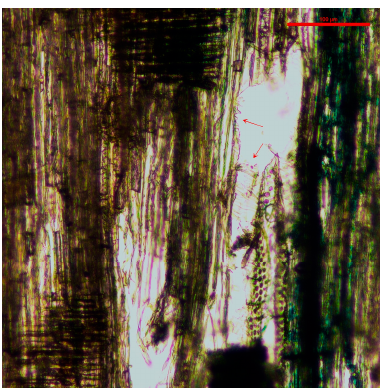
Figure 1. Radial section of a big leaf maple with red arrows pointing the helical thickenings on the vessel cell walls. Magnification 200 × .